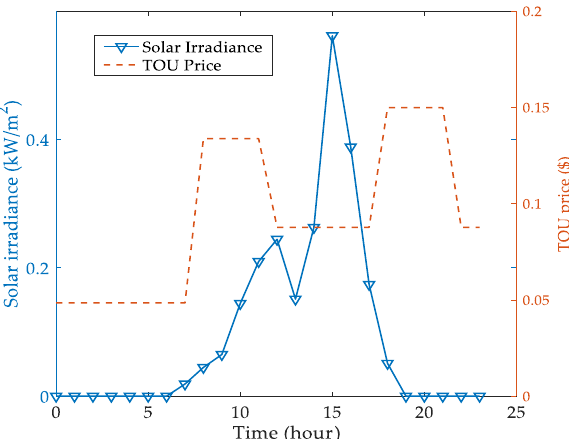
Figure 3. Scenario diagram of the hybrid power system.